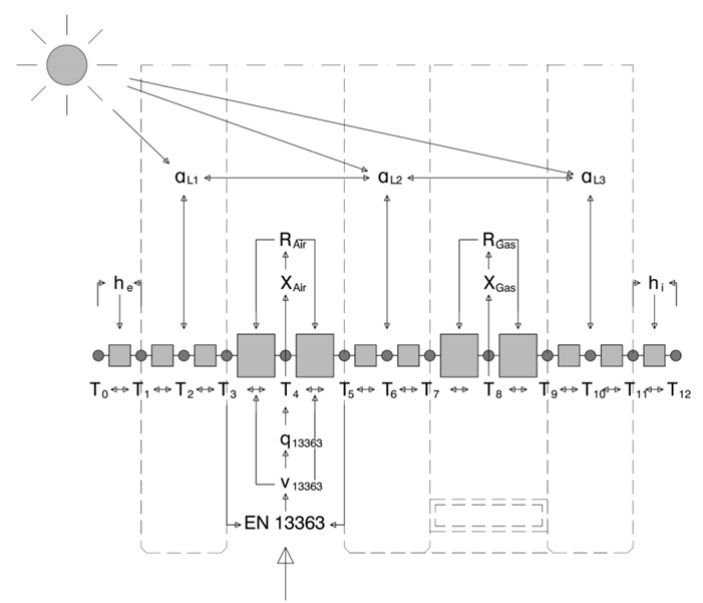
Fig. 1 Scheme of the calculation model in Excel shown as DSF with